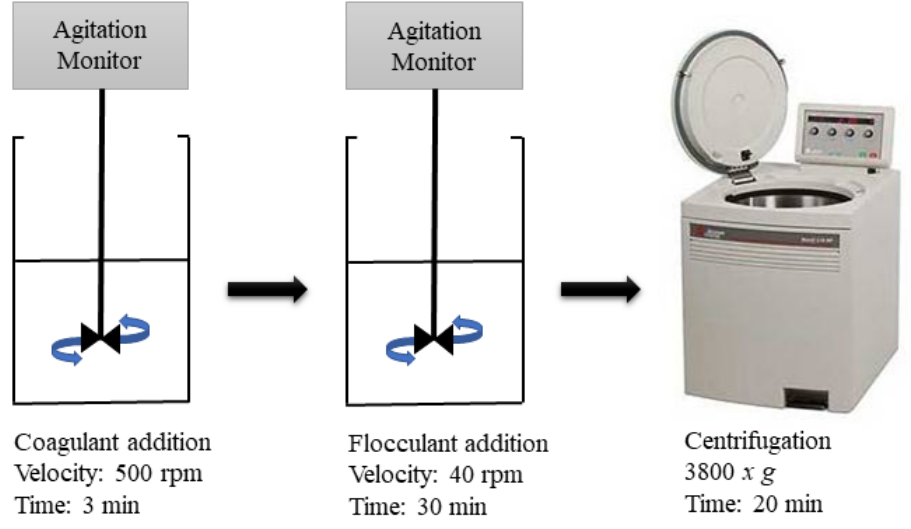
Figure 2. Schematic representation of the coagulation/flocculation process.